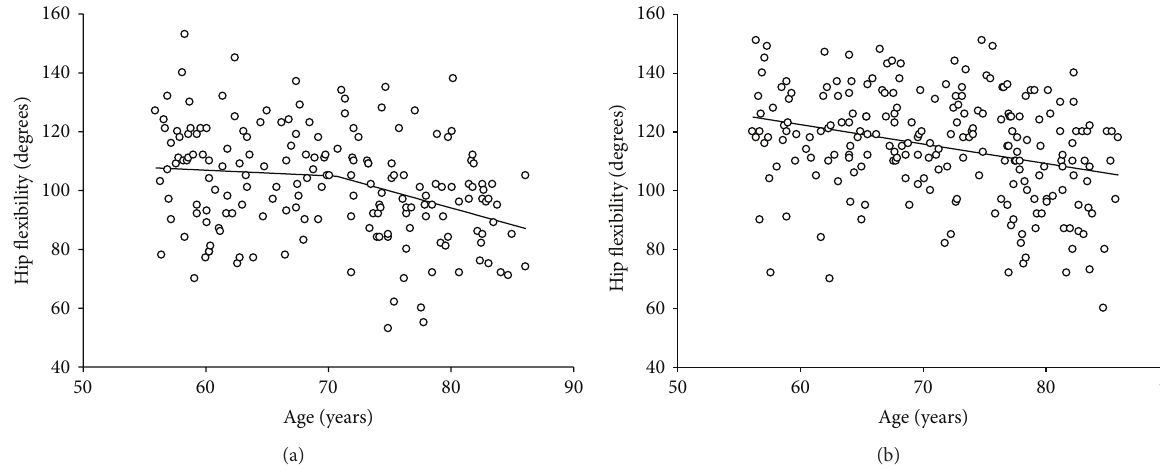
Figure 2: (a) Age analysis for hip flexion in men. Piecewise linear regression s-segment model shows breaking at the age of 71 years. The rate of decline prior to 71 years is − 0.19 degrees per year and − 1.16 degrees per year thereafter. ( 𝑅 2 of fit 𝑅 2 = 0.11 ). (b) Age analysis for hip flexion in women. Piecewise linear regression s-segment model shows breaking at the age of 86 years. The rate of decline prior to 86 years is − 0.66 degrees per year and − 2.67 degrees per year thereafter. ( 𝑅 2 of fit 𝑅 2 = 0.08